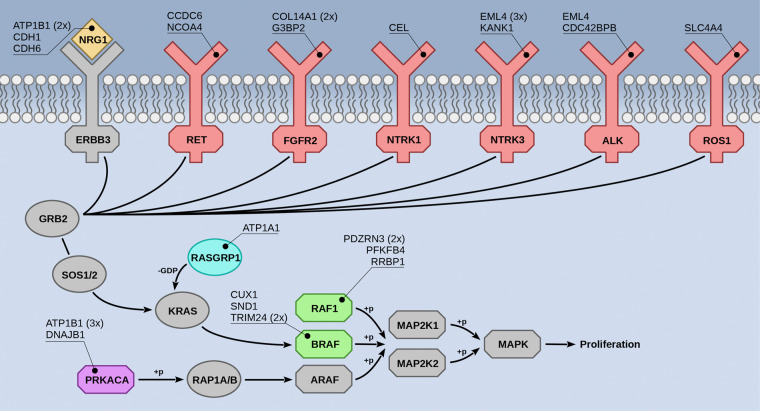
Gene fusions in pancreatic cancer. Overview of proteins in the MAPK signaling pathway found to be fused in pancreatic tumors. Colored proteins were fused to one of the genes listed in the callouts. Proteins shown in gray were not found to be fused. The frequencies of recurrent fusion partners are indicated in parentheses. The detailed structure of all fusions is depicted in Supplemental Figure S6.